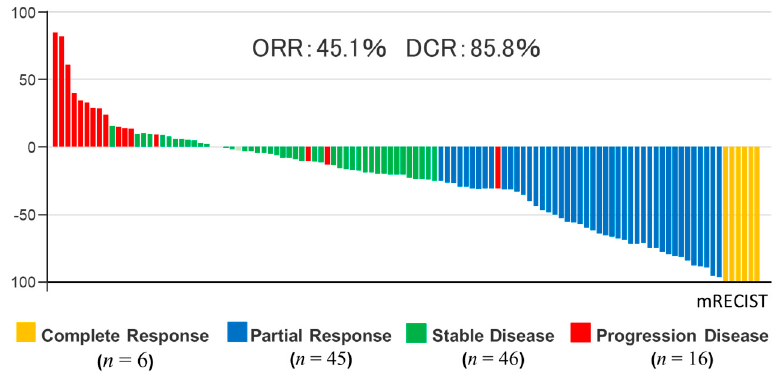
Figure 1. Waterfall plot showing maximum changes in tumor size in patients treated with lenvatinib (LEN). The waterfall plot was performed by the initial response to LEN evaluated. Target regions of tumors were examined according to the Modified Response Evaluation Criteria in Solid Tumors (mRECIST) system.